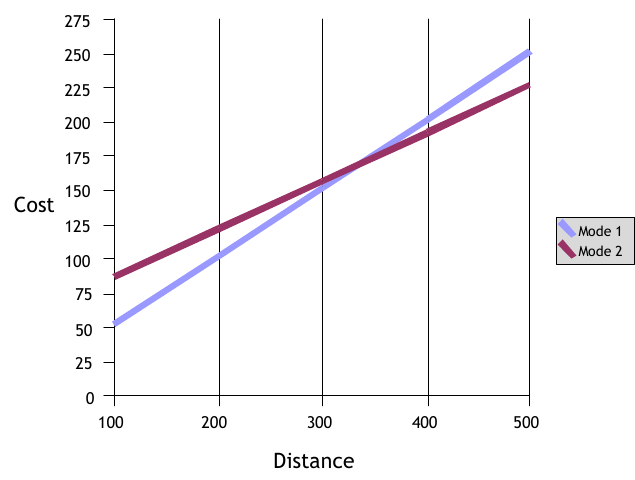
Figure 5. Modified cost